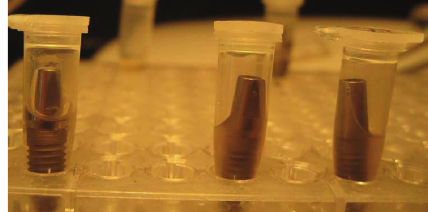
Figure 2: Kaplan-Meier survival curve.